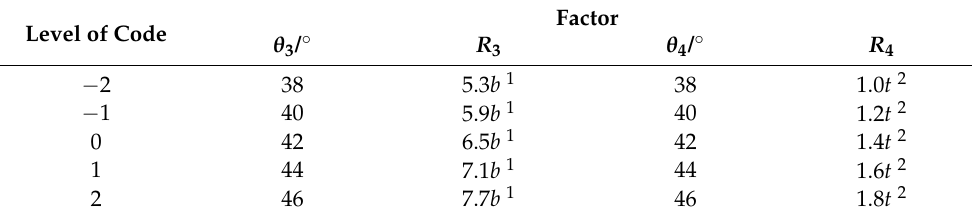
Table 2. Levels of geometric parameter factors of the training wall (operational state of free-draining). Level of Code